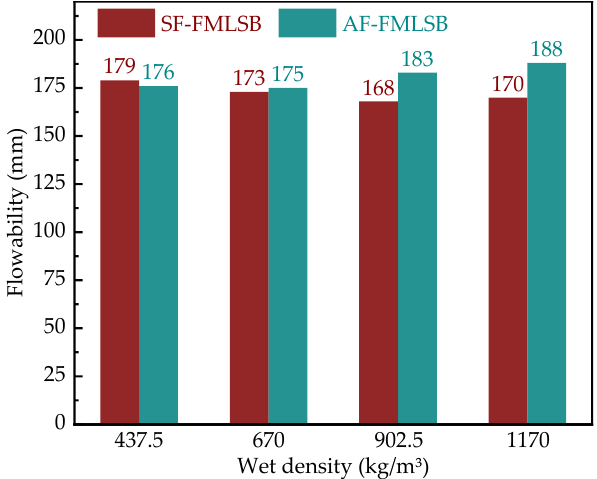
Figure 11. Fluidity of SF-FMLSB and AF-FMLSB.